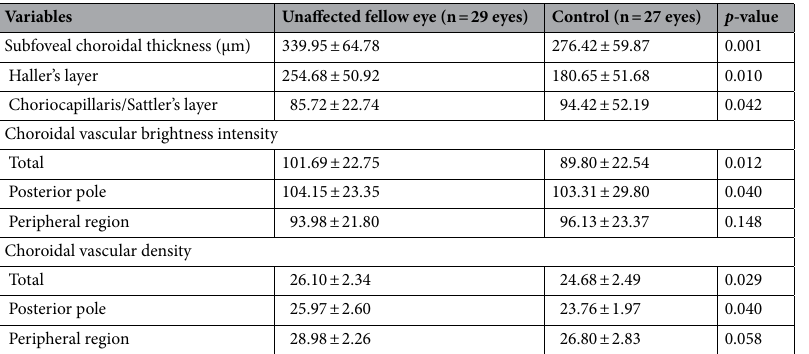
Table 4. Comparison of choroidal parameters between unaffected fellow eyes of unilateral PCV and normal controls. PCV polypoidal choroidal vasculopathy.